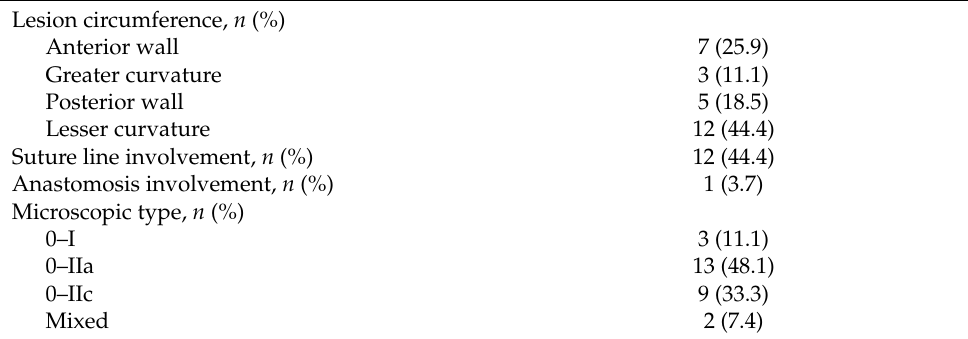
Table 2. Lesion characteristics ( n =